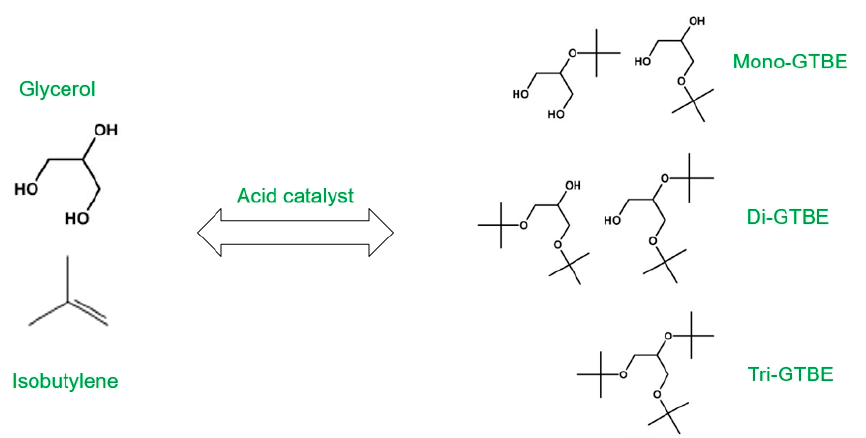
Figure 5. GTBE manufacturing reaction.